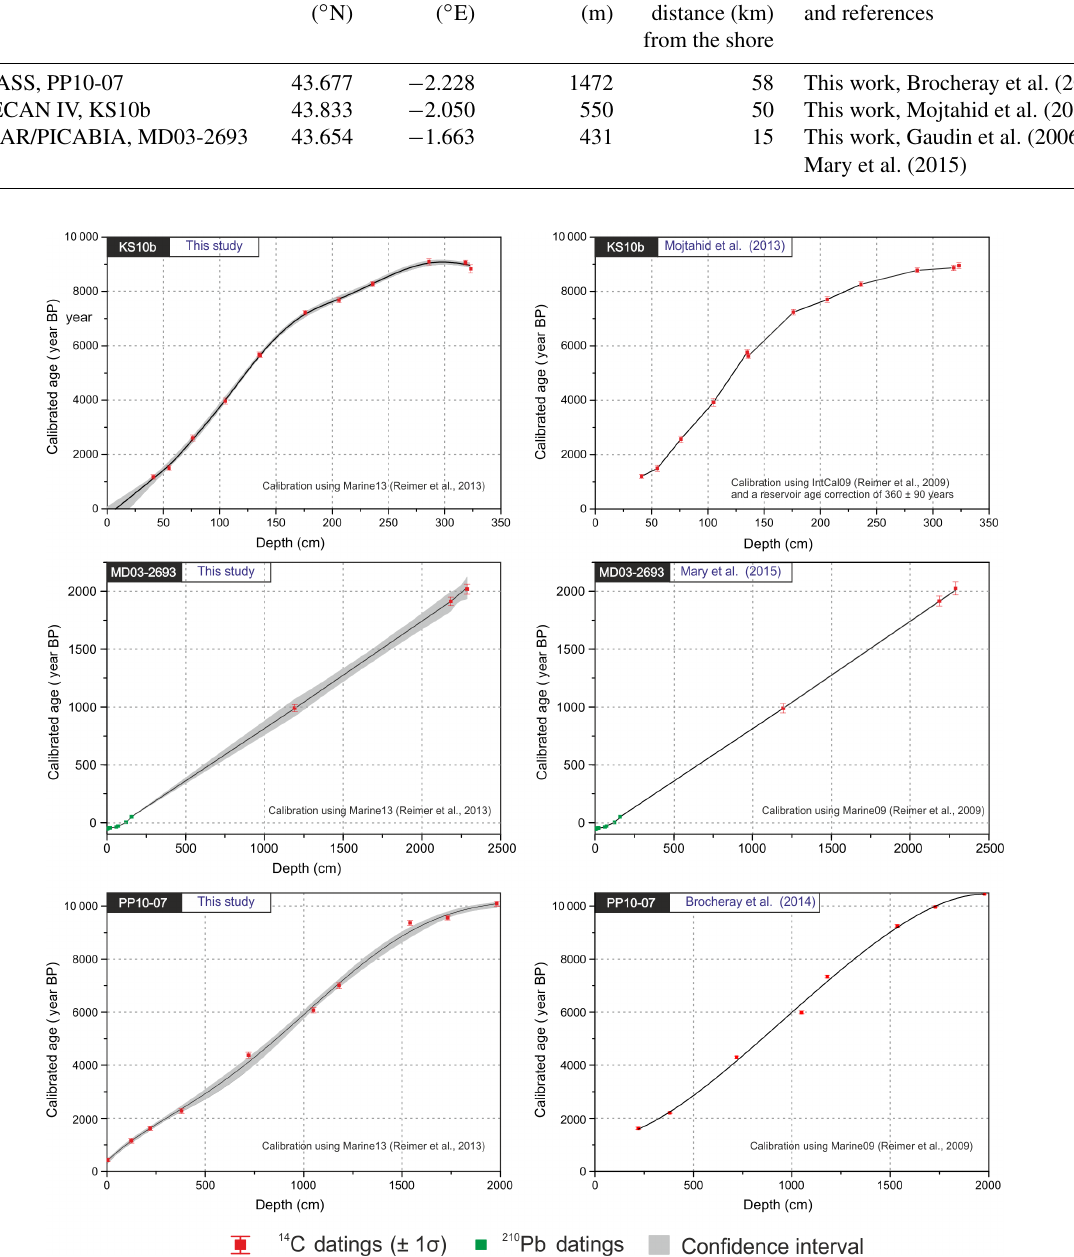
Table 1. Location and references of the southern Bay of Biscay cores used in this study. Cruise, Core label